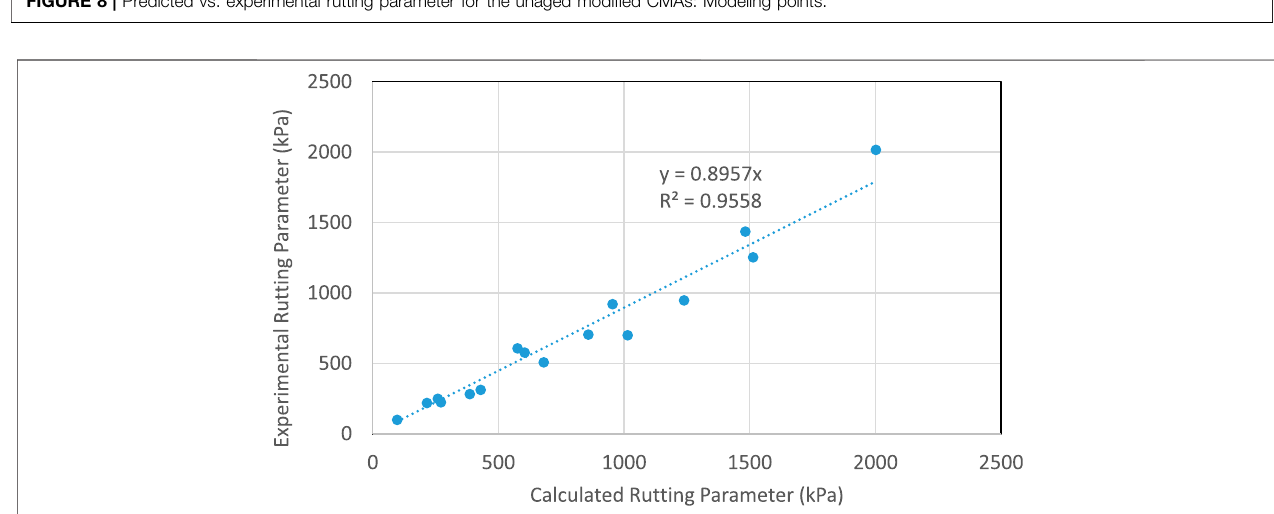
FIGURE 9 | Predicted vs. experimental rutting parameter for the unaged modi fi ed CMAs: Testing (validation) points.